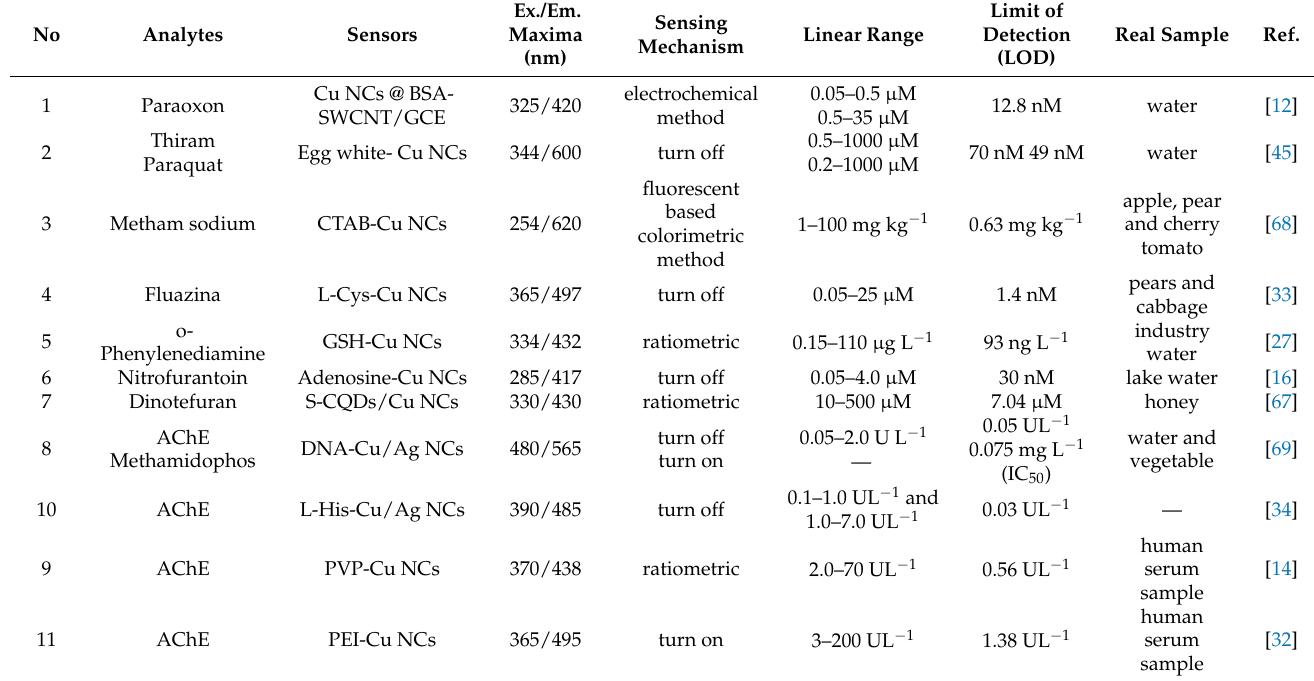
Figure 1. ( a ) Schematic representation of biosensor fabrication and suggested mechanism for paraoxon reduction; ( b ) (b1) The schematic illustration of ratiometric determination of dinotefuran based on S-CQDs/CuNCs probe; (b2) the emission spectra of S-CQDs and S-CQDs/CuNCs with and without the addition of DNF; (b3) selectivity analyses of as-developed ratiometric fluorescent probe mixed various interfering chemicals. Table 1. List of fluorescent probes based on Cu NCs for pesticide detection.